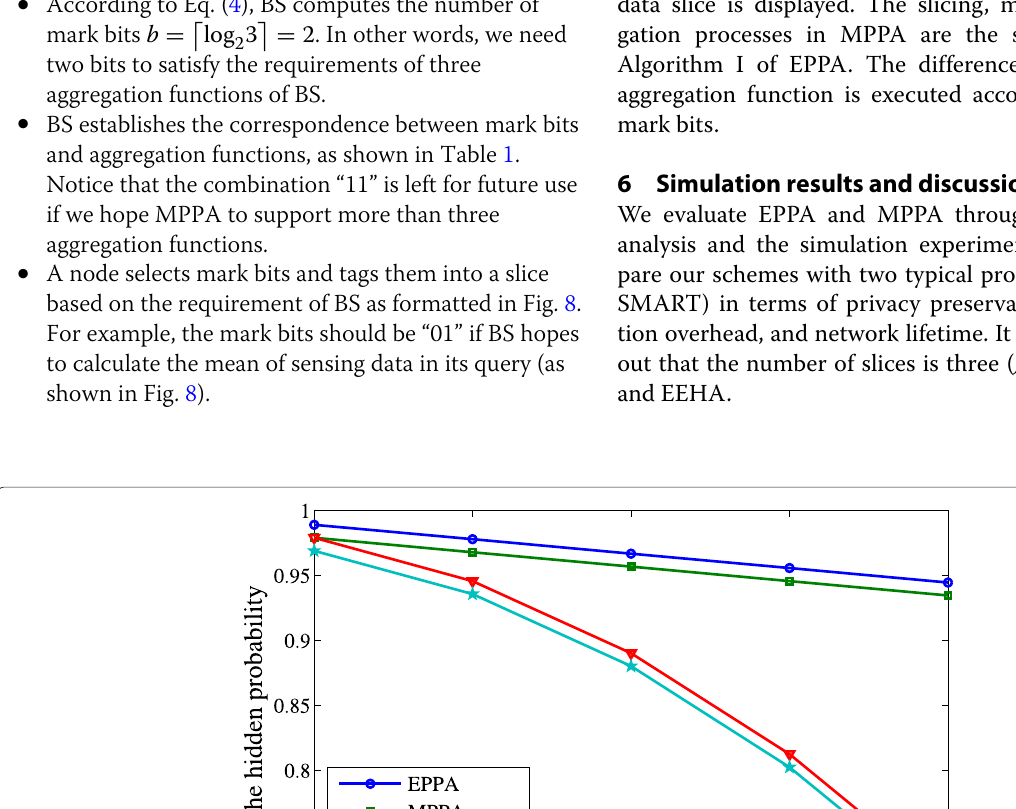
take three aggregation functions as an example (e.g., f = 3 in Eq. 4). • According to Eq. (4), BS computes the number of (cid:4) (cid:5) = 2 . In other words, we need log 3 mark bits b = 2